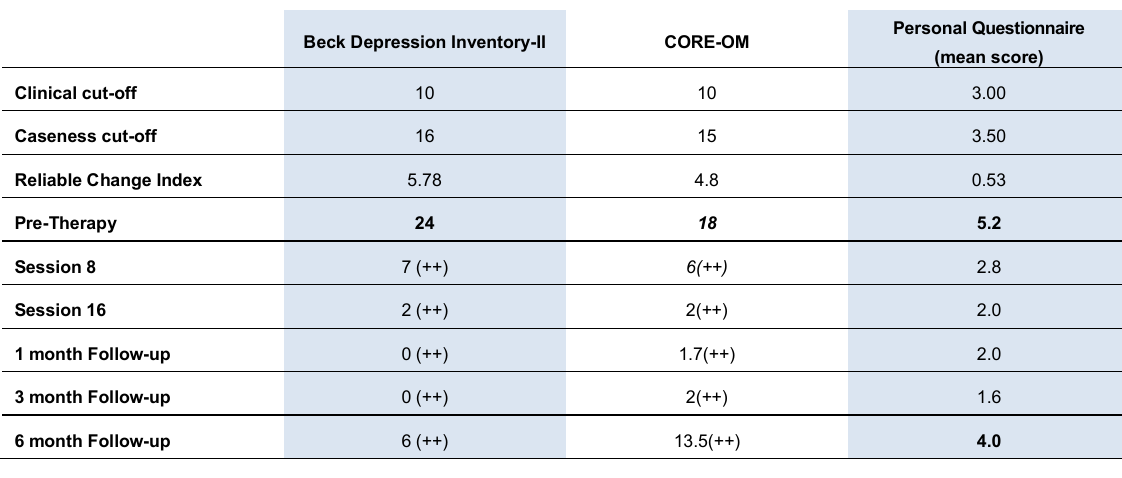
Table 1: Tom’s Quantitative Outcome Data